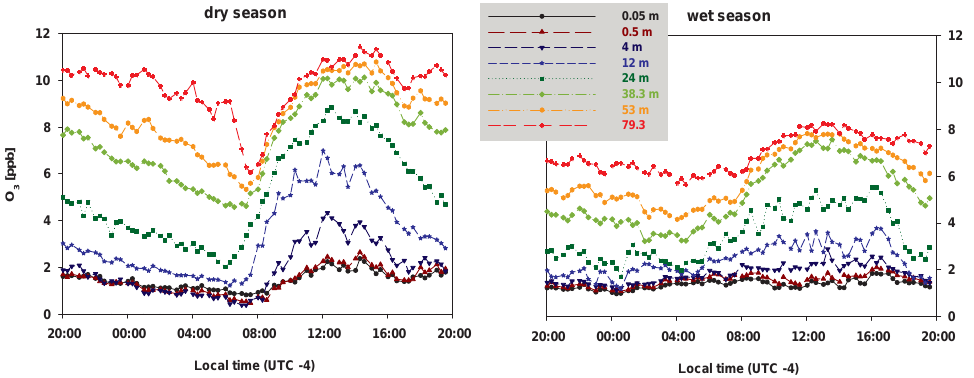
Figure 24. Mean diurnal profiles of O 3 mixing ratios measured on the walk-up tower during the dry season (left panel, 15 August to 14 September 2013) and the wet season (right panel, 1 February to 3 March 2014).